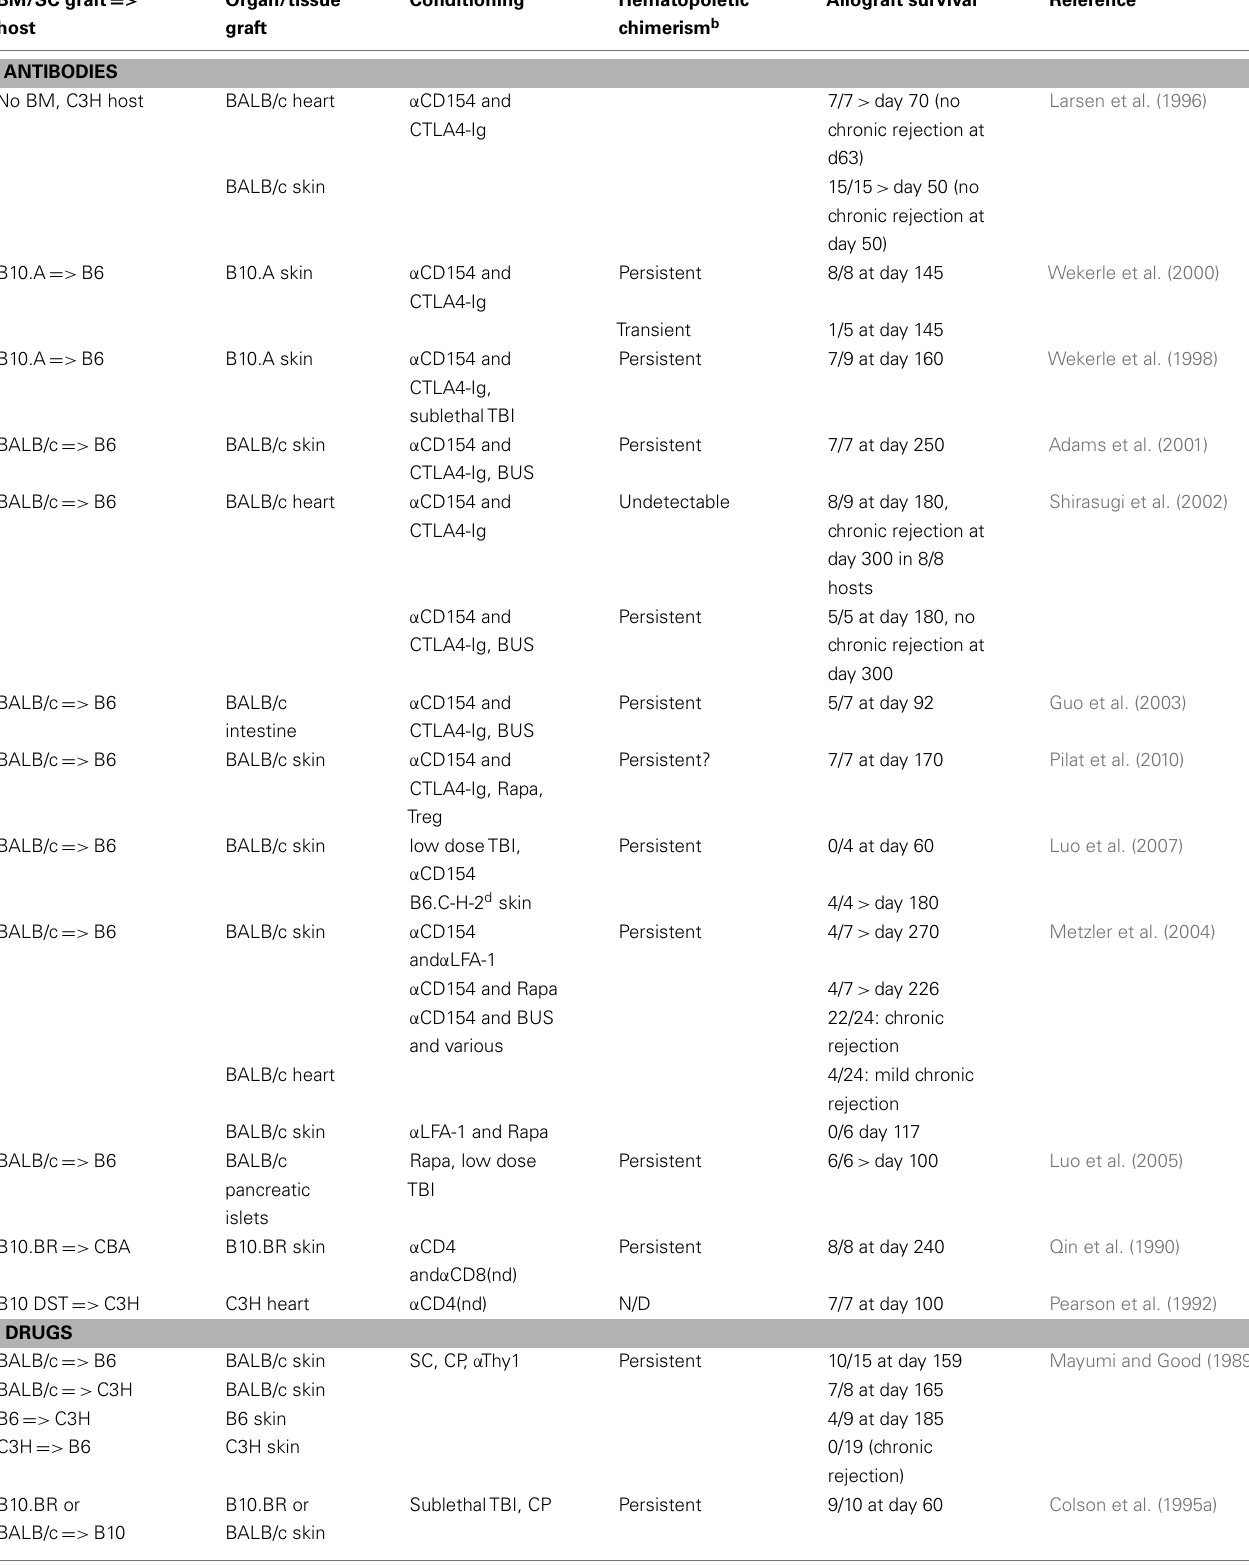
Table 1 | Combined bone-marrow and organ transplantation in the mouse: non-myelo- and lymphoablative procedures. BM/SC graft =